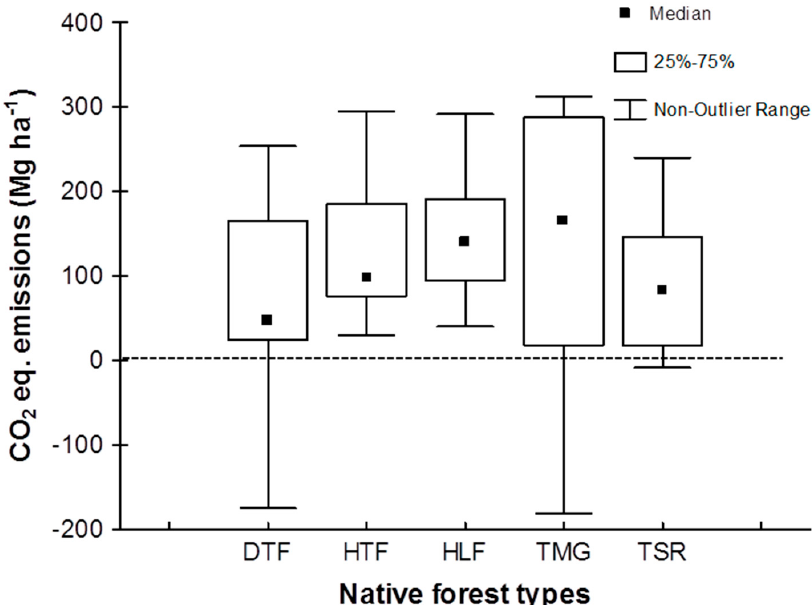
Figure 3. CO 2 equivalent emissions (Mg ha − 1 ) related to soil organic carbon depletion from forest to pastureland conversion in Mexico. DTF: dry tropical forests; HTF: humid tropical forests; HLF: highland forests; TMG: tropical mangroves; and TSR: tropical scrubs and rangelands.